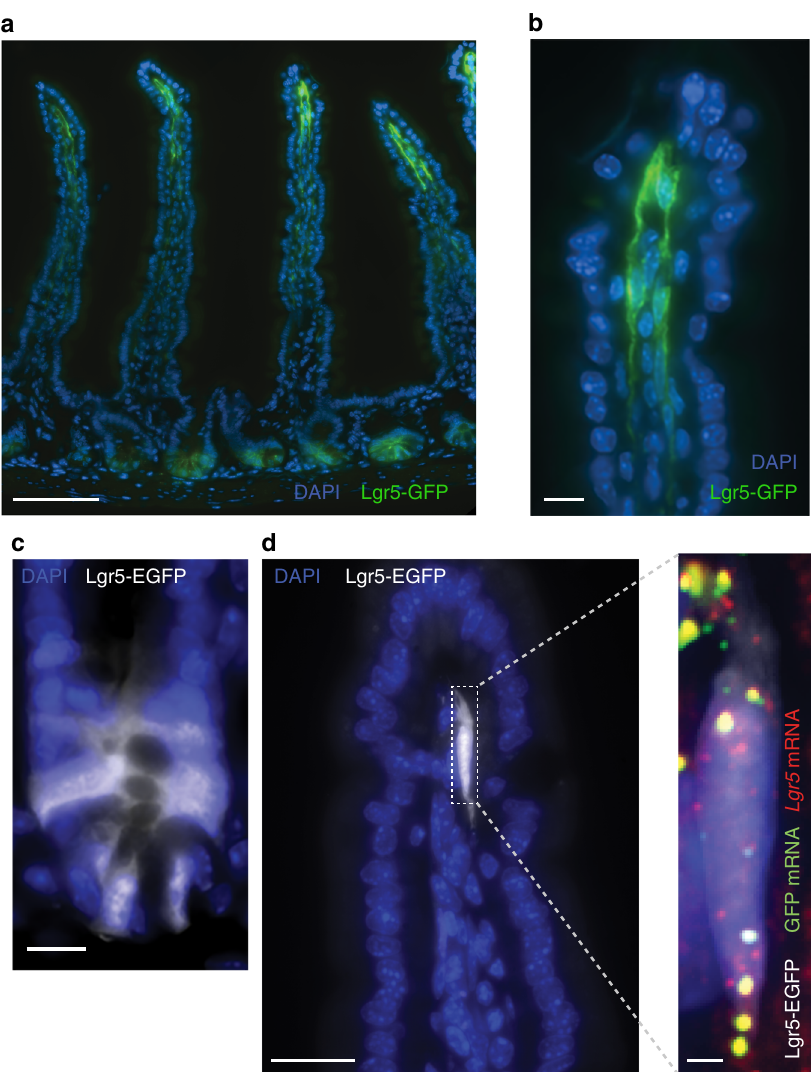
Fig. 3 Lgr5 expression at the villus tip of Lgr5-knock-in mouse models. a GFP fl uorescence (green) observed in both crypt base columnar cells (CBCs) and VTTs in Lgr5 – GFP-DTR mice. Scale bar – 100 µ m. b blow up of villus tip with GFP + VTTs, scale bar – 10 µ m. c EGFP fl uorescence of crypt base columnar cells in Lgr5-EGFP-IRES-creERT2 mice. Scale bar – 10 µ m. d EGFP fl uorescence in VTTs. The Lgr5-EGFP knock-in construct is expressed in a patchy manner in the villus tip stroma. Scale bar – 20 µ m. Blow up shows Lgr5 mRNAs in red, EGFP mRNA in green and DAPI in blue. Scale bar – 2 µ m. Yellow blobs are auto fl uorescent